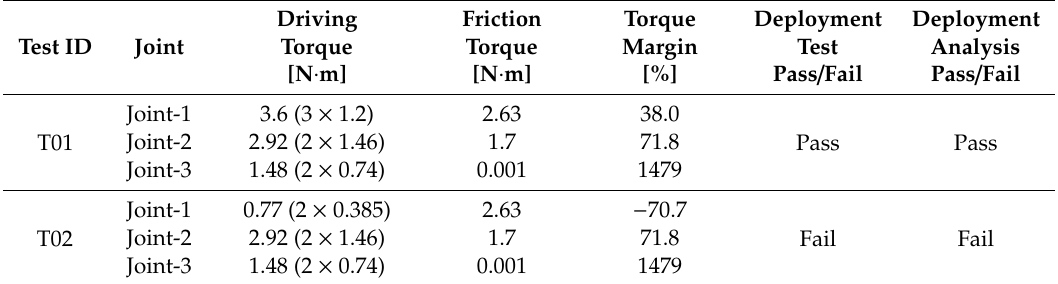
Table 5. Torque margin for all test